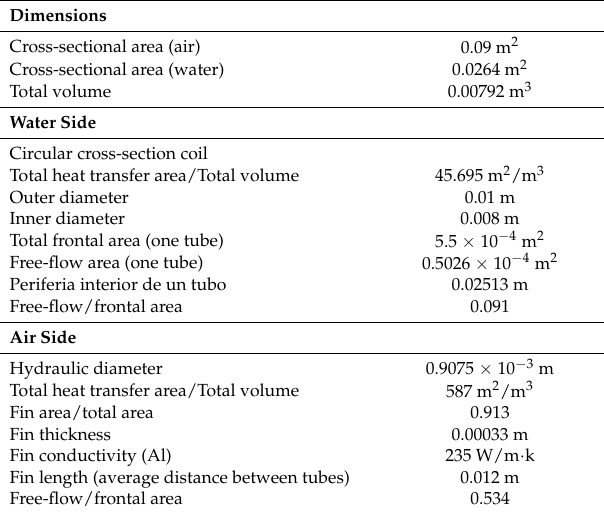
Table 4. Geometric characteristics of the heat exchanger